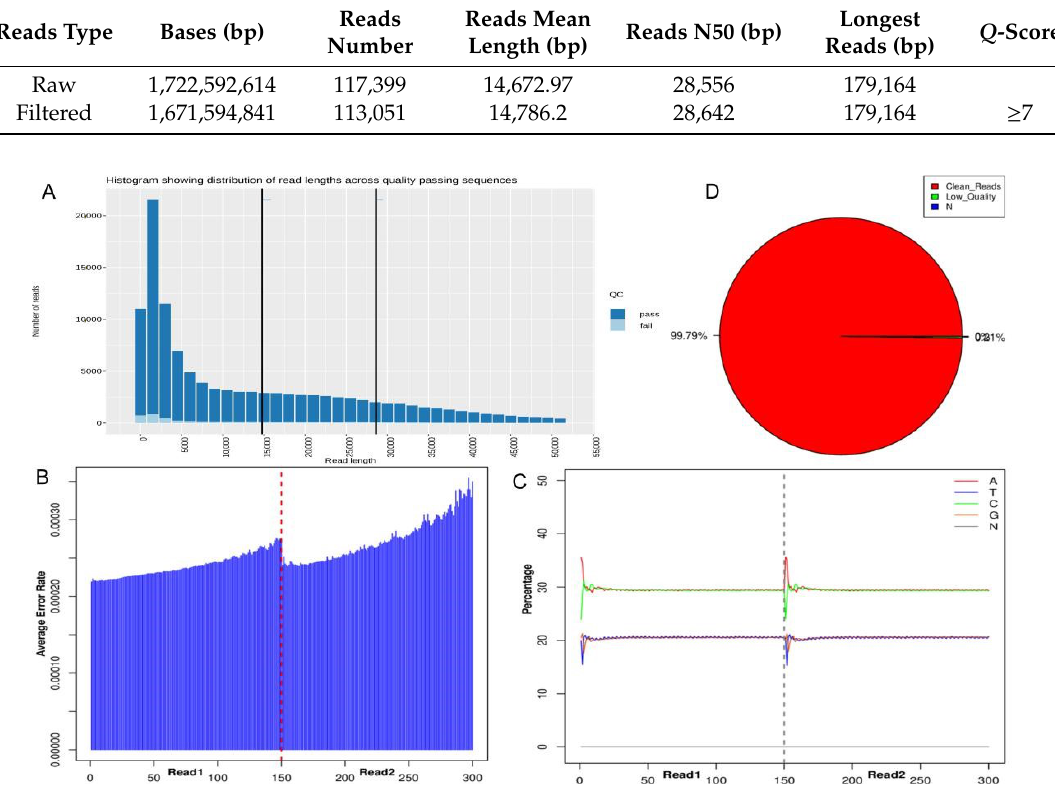
Table 1. Sequencing information of L. sakei via Nanopore.